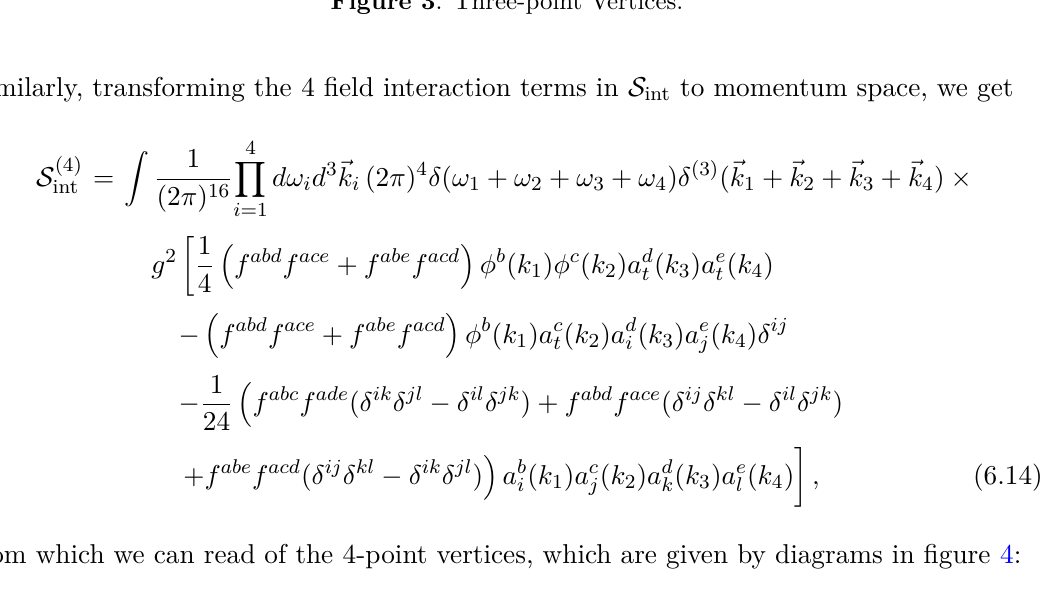
Figure 3 . Three-point